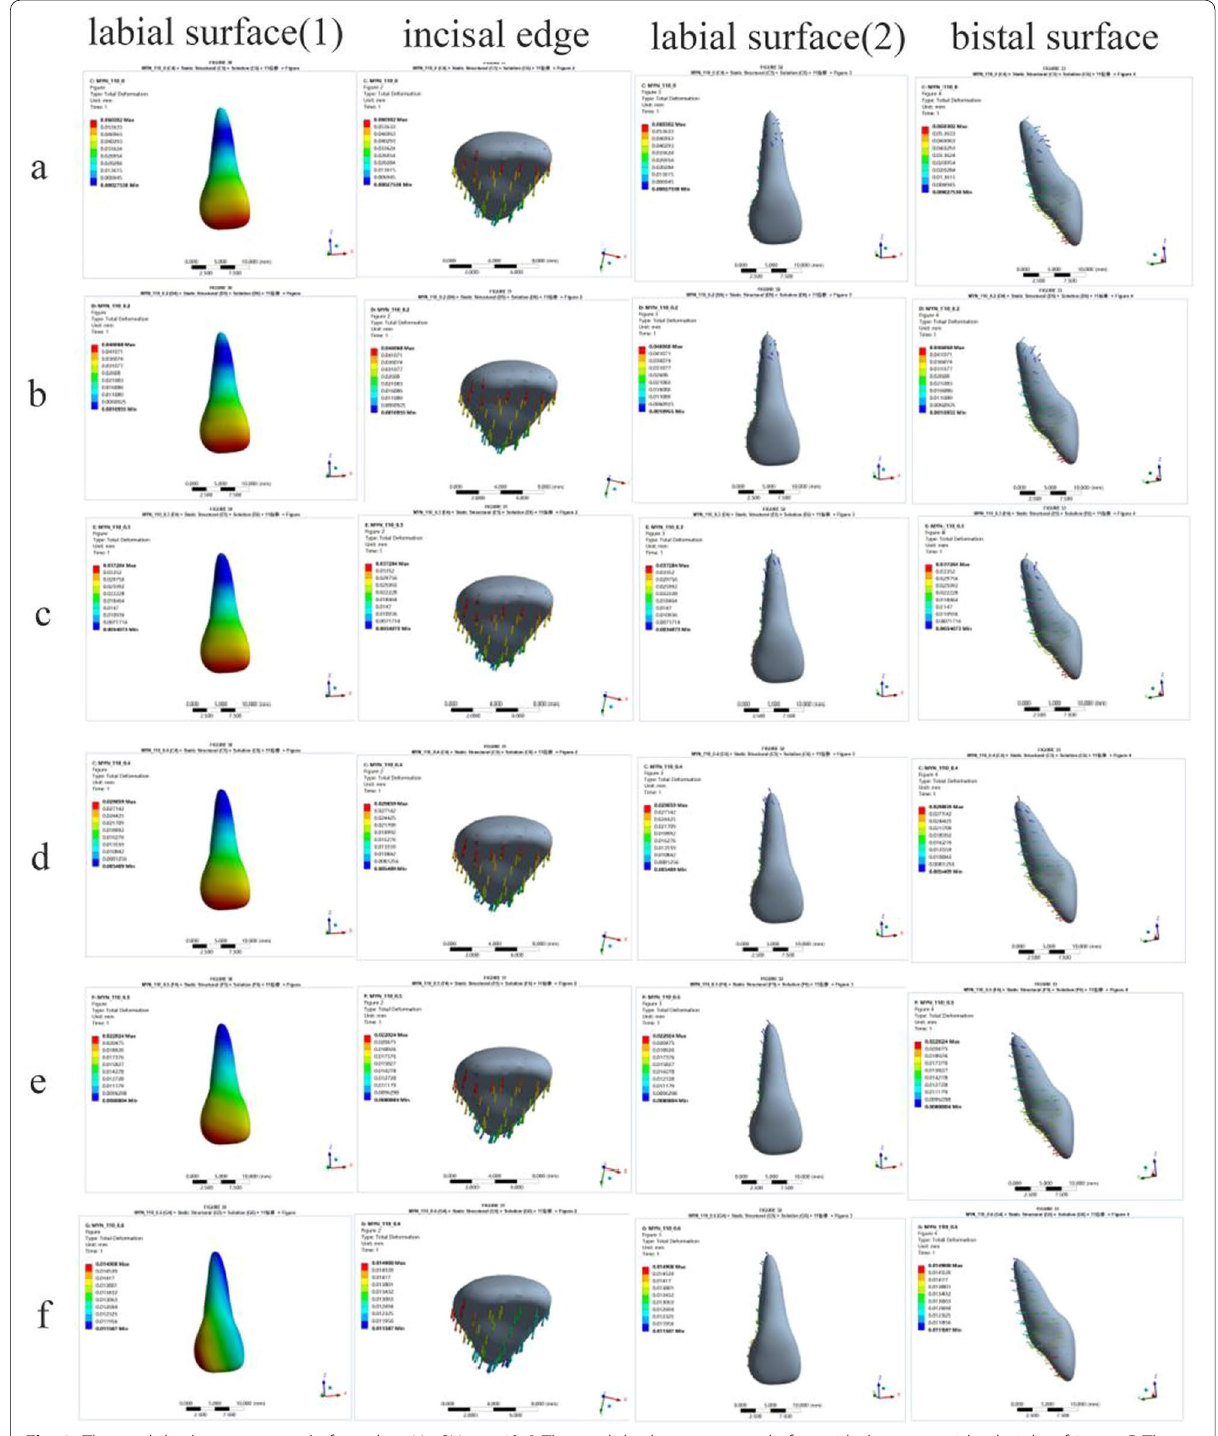
Fig. 3 The total displacement trend of 11 when U1-SN 110°. A The total displacement trend of 11 with the torque ridge height of 0 mm. B The = total displacement trend of 11 with the torque ridge height of 0.2 mm. C The total displacement trend of 11 with the torque ridge height of 0.3 mm. D The total displacement trend of 11 with the torque ridge height of 0.4 mm. E The total displacement trend of 11 with the torque ridge height of 0.5 mm. F The total displacement trend of 11 with the torque ridge height of 0.6